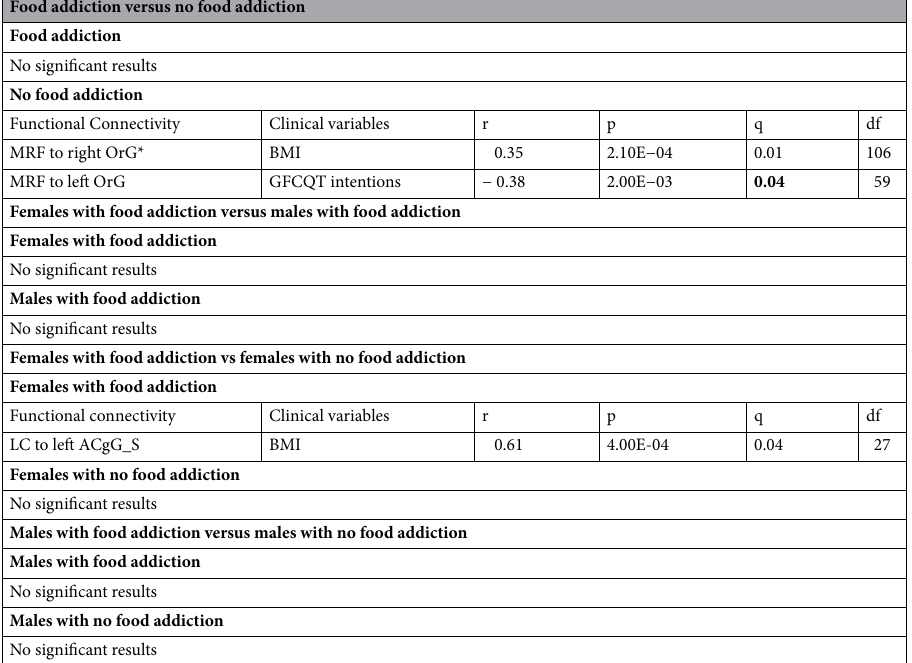
Table 6. Associations between significant functional connectivities and clinical variables. Summarizes correlations between functional connectivity and clinical variables. Comparisons include disease differences (individuals with food addiction vs. individuals with no food addiction), sex differences (females with food addiction vs. males with food addiction), disease effect within females (females with food addiction vs. females with no food addiction), and disease effect within males (males with food addiction vs. males with no food addiction). All connections are significant q < 0.05. *Right ContB_PFClv_3. ACgG_S, Middle-anterior part of thecingulate gyrus and sulcus; BMI, Body Mass Index; GFCQT, General Food Cravings Questionaire—Trait; LC, locus coeruleus; MRF, Mesencephalic reticular formation; OrG, Orbital gyri. r: correlation, df: degrees of freedom; p value significant < .05, q value (corrected for multiple comparisons) <